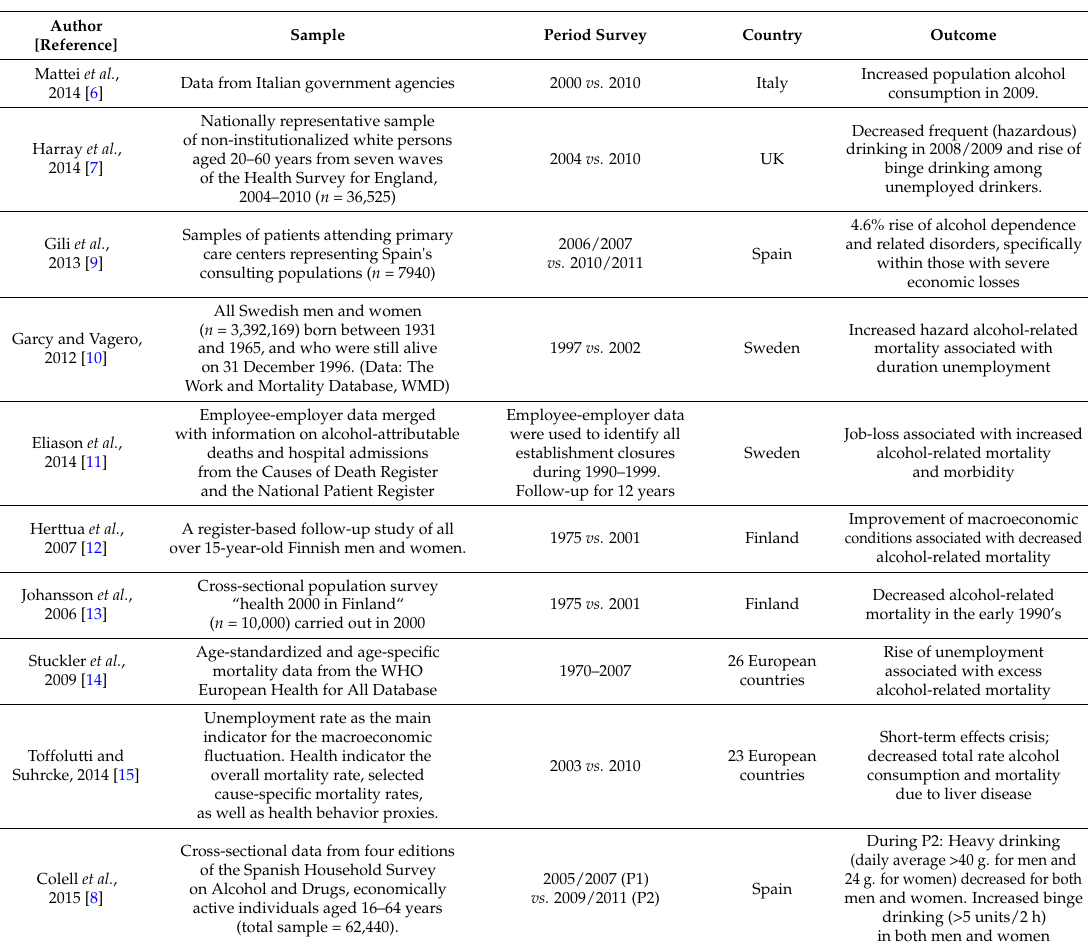
Table 1. Studies on alcohol and alcohol use disorders during and after the economic crisis in European Union